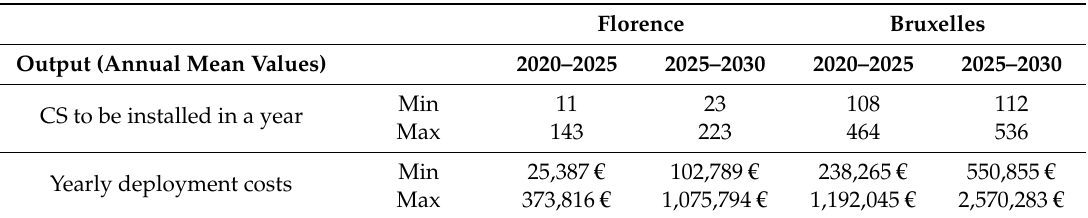
Table 15. Yearly steps to deploy the publicly accessible charging infrastructure as sized by the